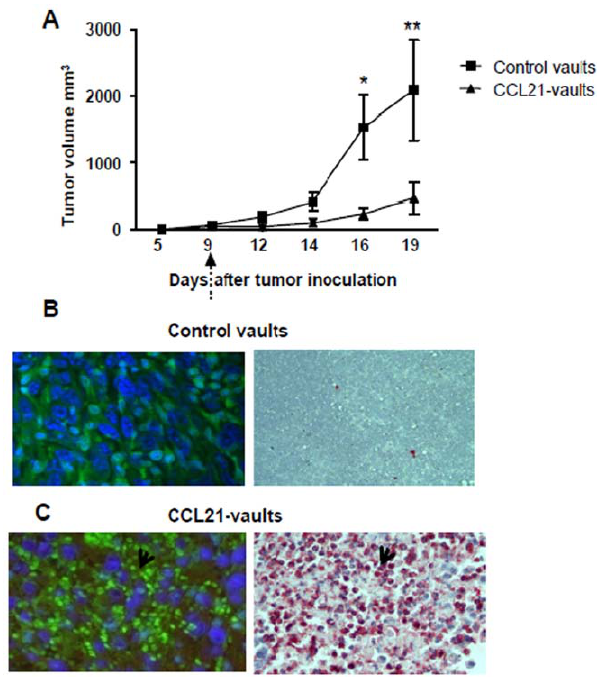
Figure 3. Intratumoral CCL21-vaults reduce tumor growth and enhance T cell leukocytic infiltrates. A. CCL21-vaults inhibited tumor growth and enhanced intratumoral T cell infiltrates in lung cancer. C57BL/6 mice bearing 9 day 3LL established tumors ( s.c. ) were treated intratumorally with control vaults (200 ng), mCCL21-vaults (200 ng) or diluent normal saline (NS). Bisecting tumor diameters were measured with calipers. B–C. mCCL21-vaults increased the influx of CD3 expressing T cells in the tumor as compared to control vaults. UBC-GFP/ BL6 mice bearing 9-day established tumors were treated intratumorally with control vaults or mCCL21-vaults. OCT frozen tissue was